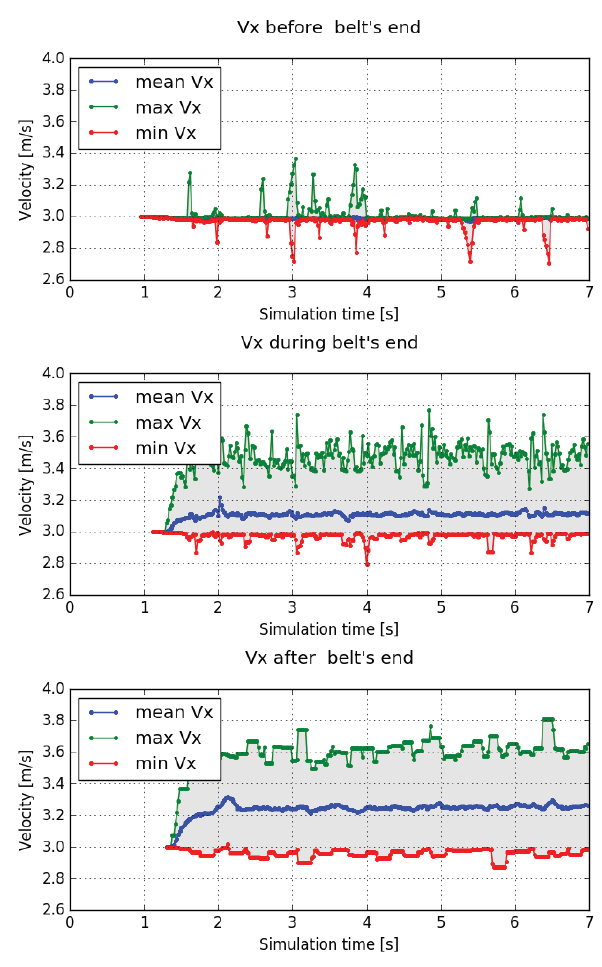
Figure 2. V x max , min , mean for all particles in each region of interest, in the base system (monodisperse material). It is clear the increase of maximum and mean V x during and after the end of the conveyor. A opposite behavior can be observed for the minimum V x , its value became < 3.0 m / s more frequently during the transition in the end of conveyor and always < 3.0m / s after the transition